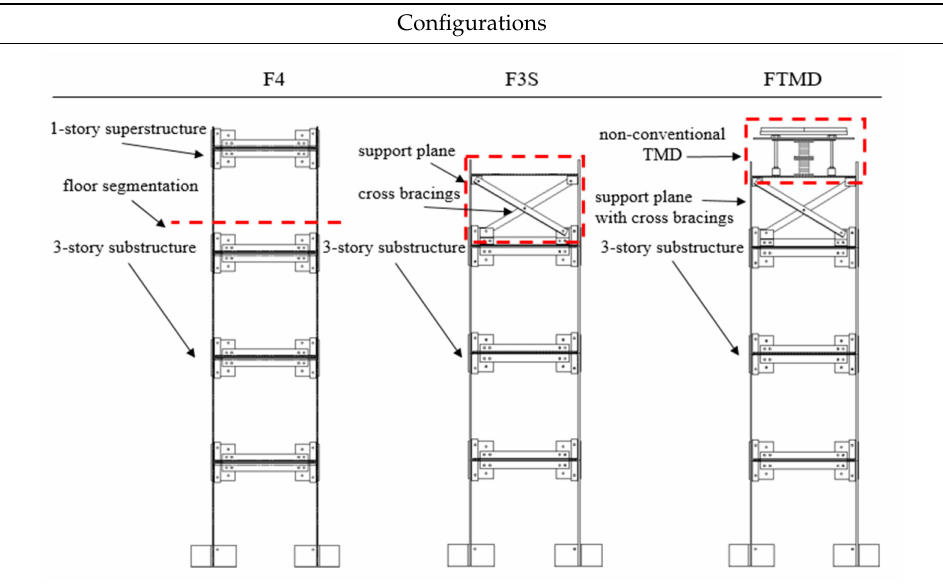
Figure 2. Four-story frame structure, configuration F4: ( a ) physical model, the circle indicates the detail of the columns’ base constraint; ( b ) vertical sections, left: section A-A, right: section B-B; ( c ) plane section. Dimensions in millimeters. Table 1. Configurations tested in the experimentation: F4—the reference 4-story structure, F3S—the 3-story structure with the rigid support plane; FTMD—the 3-story structure equipped with the non-conventional